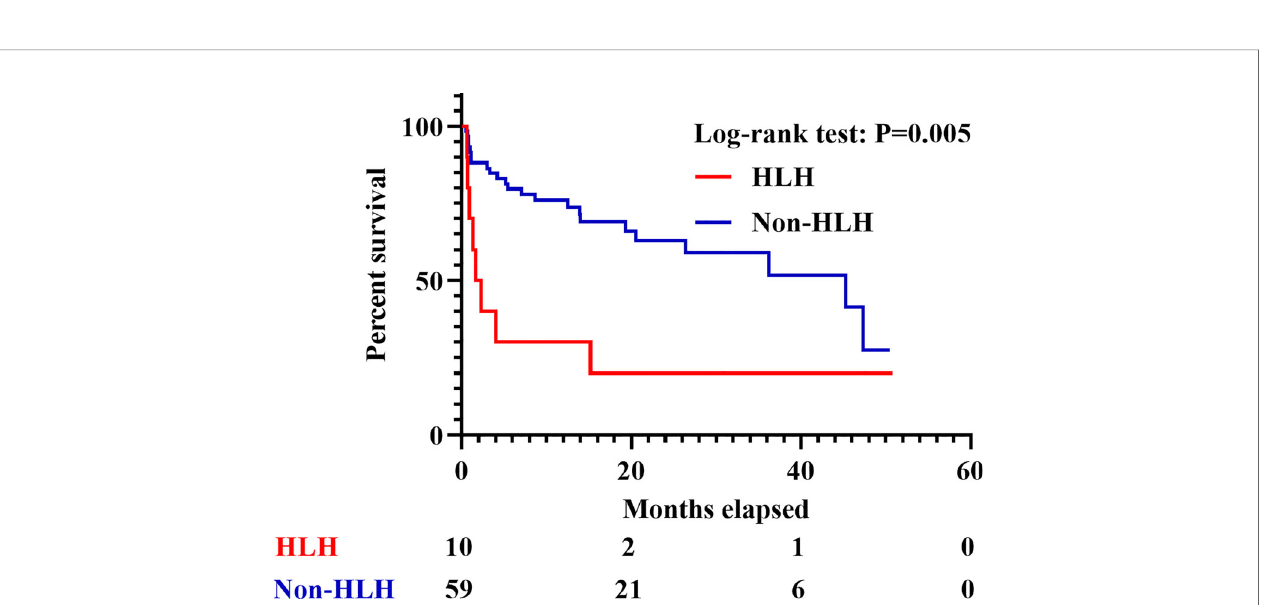
FIGURE 2 | Survival of IIM patients with or without sHLH. IIM, Idiopathic in fl ammatory myopathy; sHLH, Secondary hemophagocytic